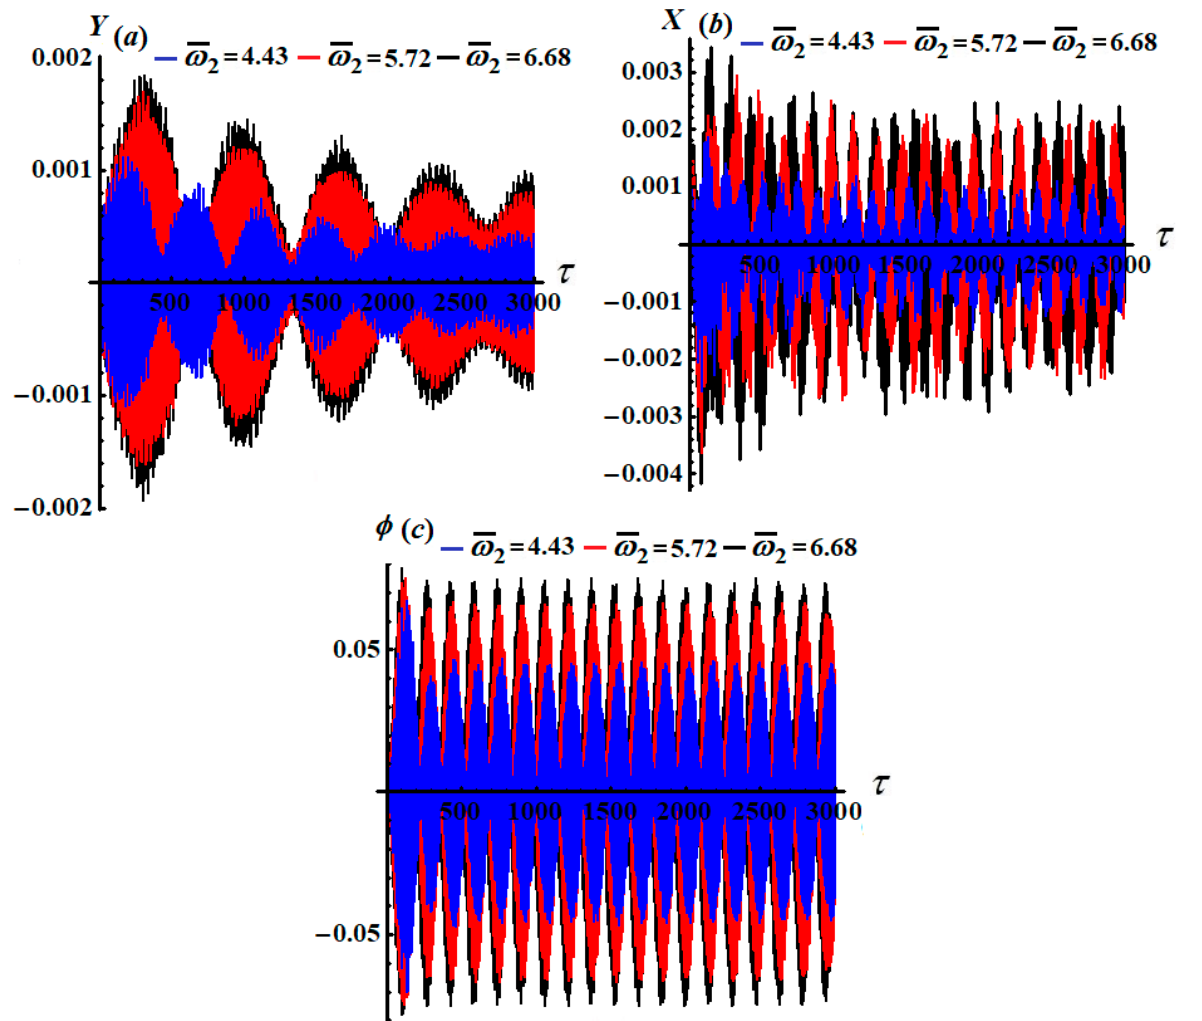
Figure 6. The time histories of the approximate solutions Y , X , and φ : ( a – c ) when ω 2 = ( 4.43,5.72,6.68 )